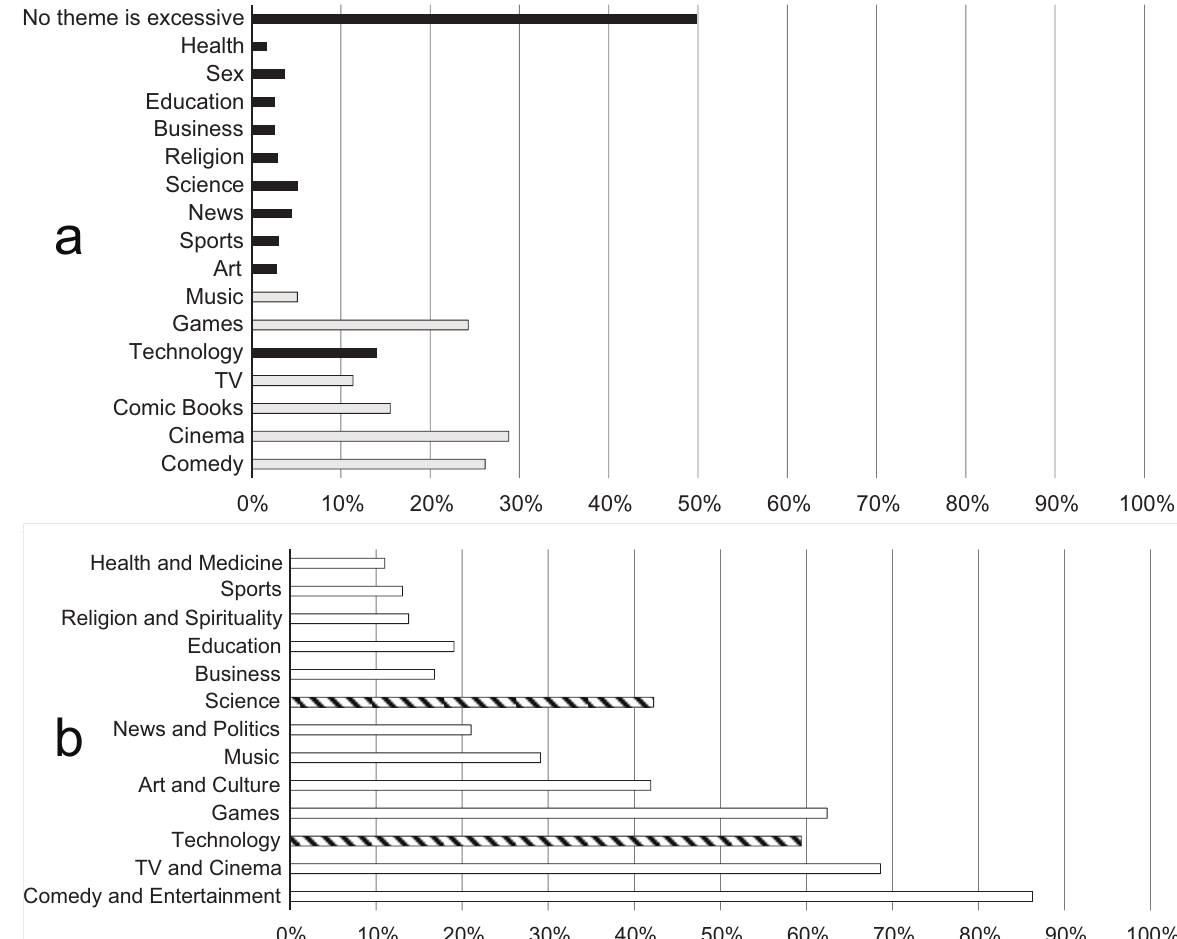
Figure 2 - a) Overexplored subjects in Podcasts, according to PodPesquisa. Topics in gray relate to the pop culture and are among those most consumed; b) Most consumed podcast subjects, according to the PodPesquisa. Pattern bars show the scientific